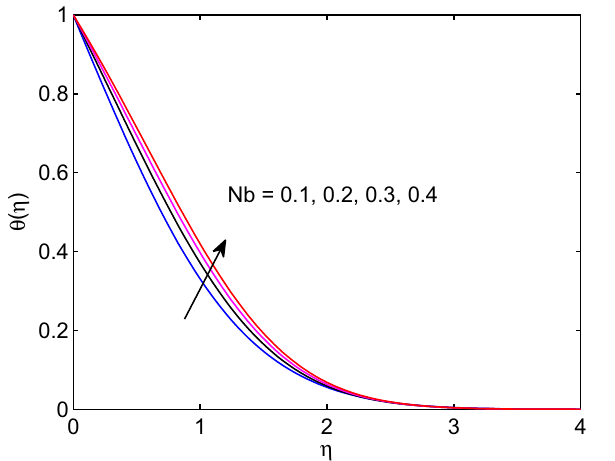
Figure 25. Brownian motion effects on temperature profiles.